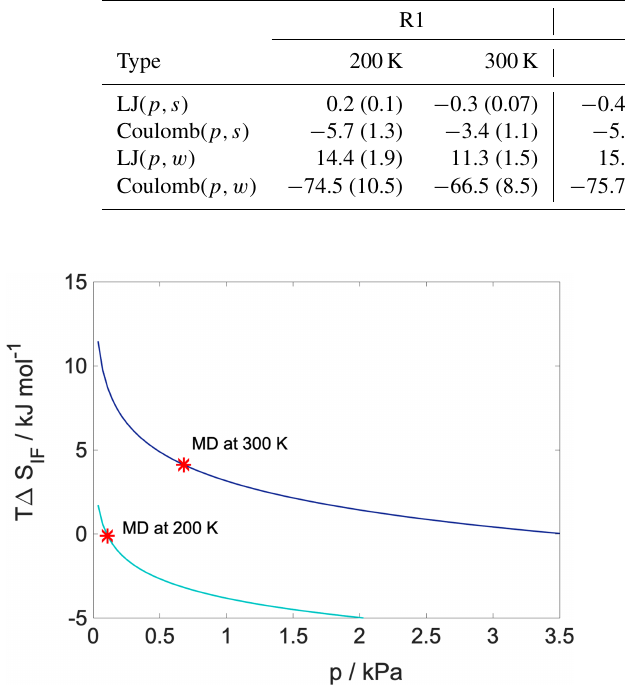
Figure B3. Modeled interfacial entropies at the simulated tempera- tures.